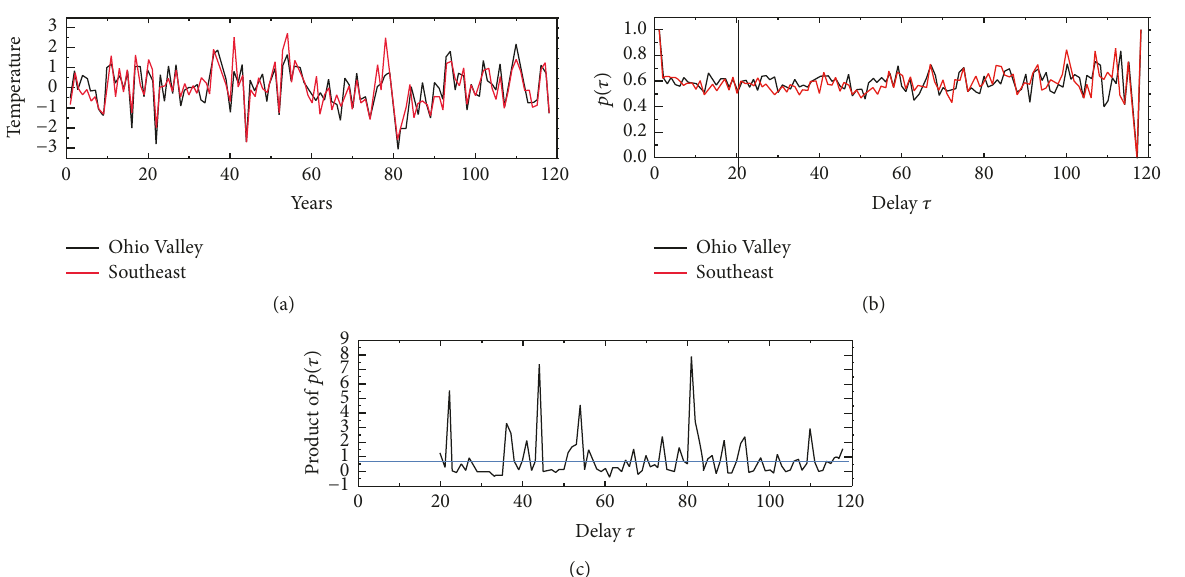
Figure 6: Evaluation of CPR from 𝑝(𝜏) . (a) Normalized yearly data for 120 years. (b) 𝑝(𝜏) curves for these time series with 𝜏 𝑠 = 20 are shown with a vertical line. (c) The product of Ohio Valley and Southeast in (b). The horizontal line is the mean of this series, which is the